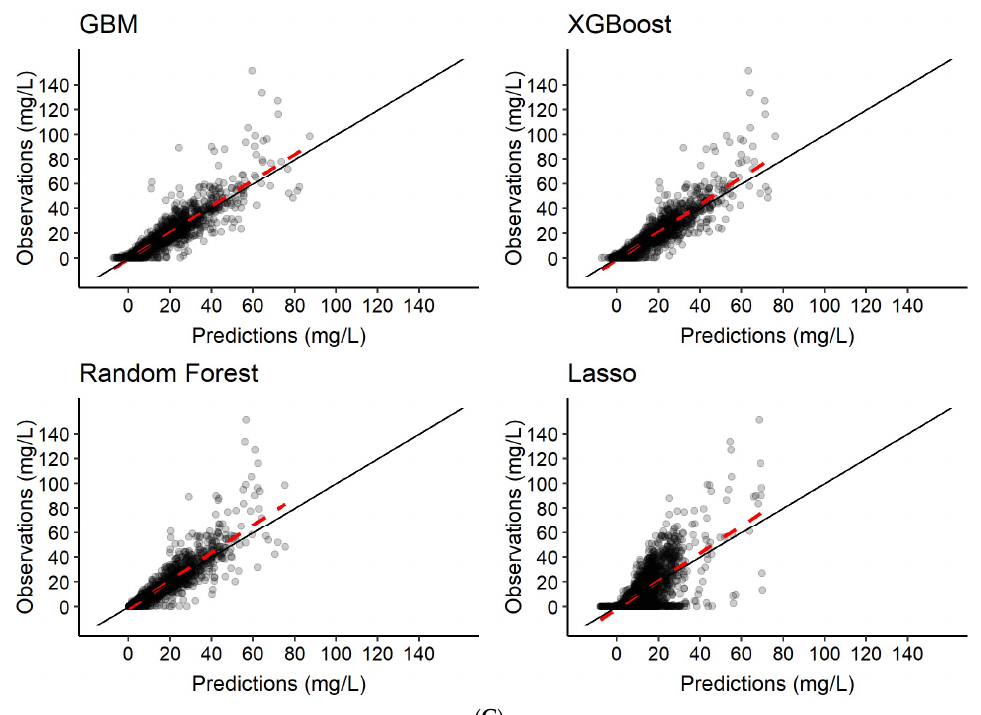
Figure 5. Predictions of rifampicin plasma concentration–time series from the different ML algorithms compared to the simulations from the population PK model, considered to be observations in this study. Panel ( A ) is the scenario where the model was trained to predict the rifampicin plasma concentration–time series using features only as input. In panel ( B ), the models were trained to predict the rifampicin plasma concentration–time series based on features and 2 plasma concentrations at time-points 2 and 4 h post-dose at days 7 and 14. In panel ( C ), the models were trained to predict the rifampicin plasma concentration–time series based on features and 6 plasma concentrations at time-points 0.5, 1, 2, 4, 8 and 24 h post-dose at days 7 and 14. The red dashed line represents a trendline through the data. The black solid line is the line of identity, indicating 100% agreement between true and predicted values.